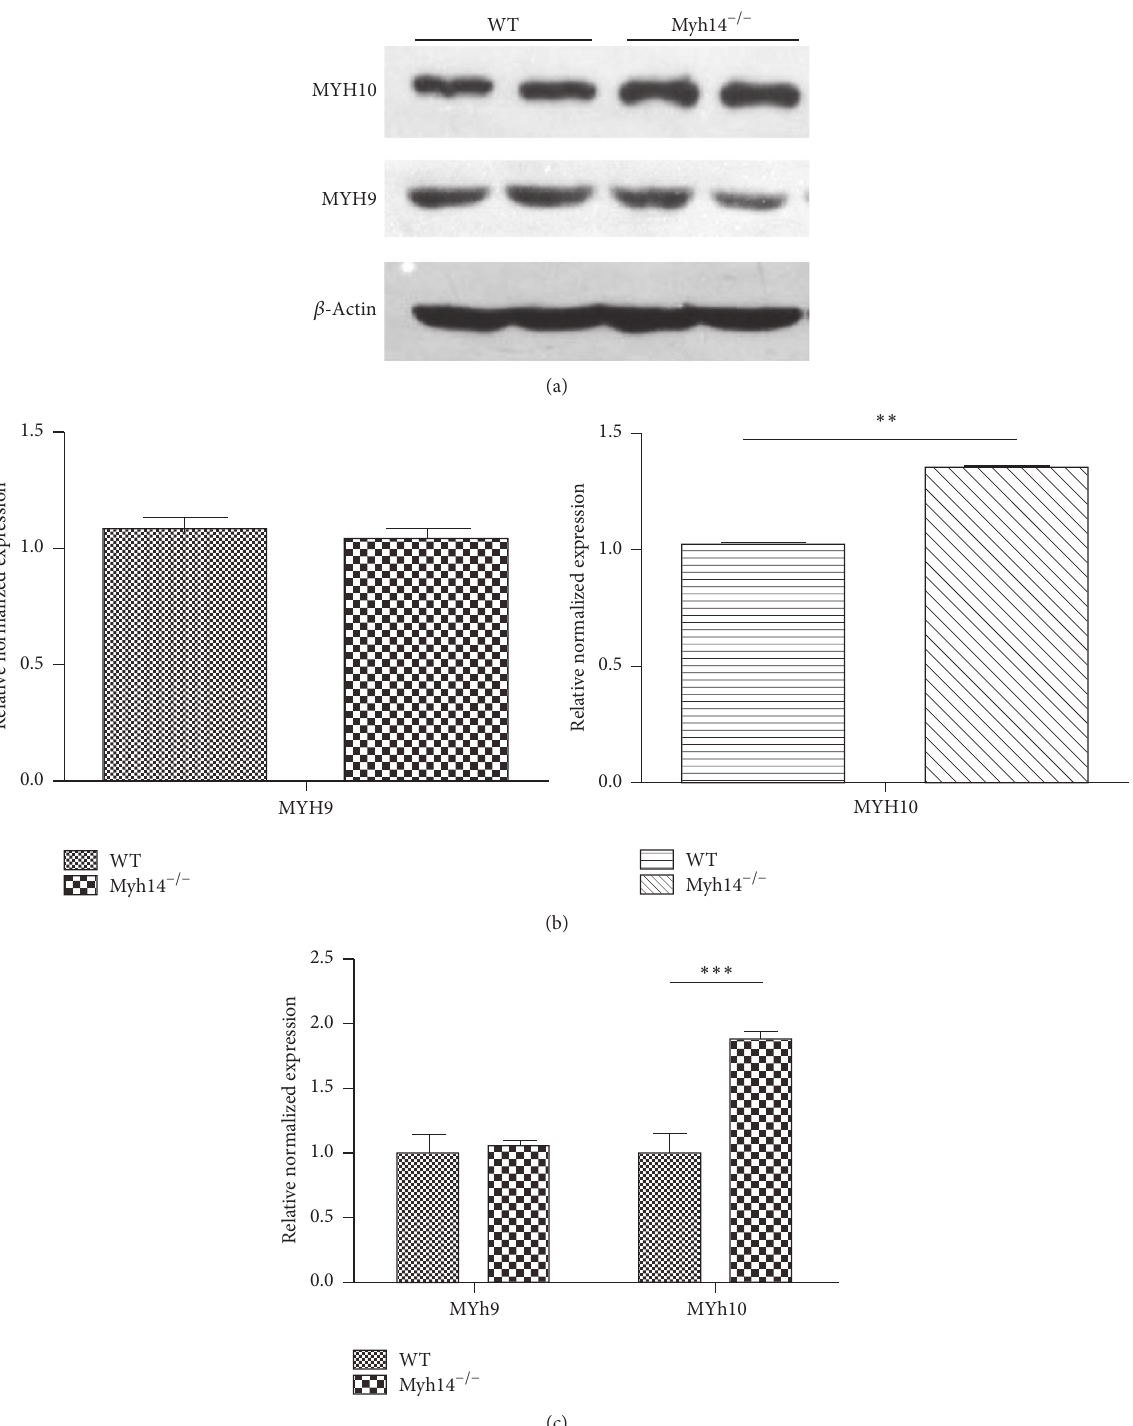
Figure 10: The expression level of MYH9 and MYH10 after the noise exposure. ((a), (b)) Western blots analysis was performed to show the expression level of MYH9 and MYH10 after the noise exposure ( 𝑛 = 3 for each group). (c) The consequence of Western blots was verified by real-time PCR. ∗∗ 𝑃 < 0.01 compared to the controls. ∗∗∗ 𝑃 < 0.001 by Student’s 𝑡 -test compared to the control